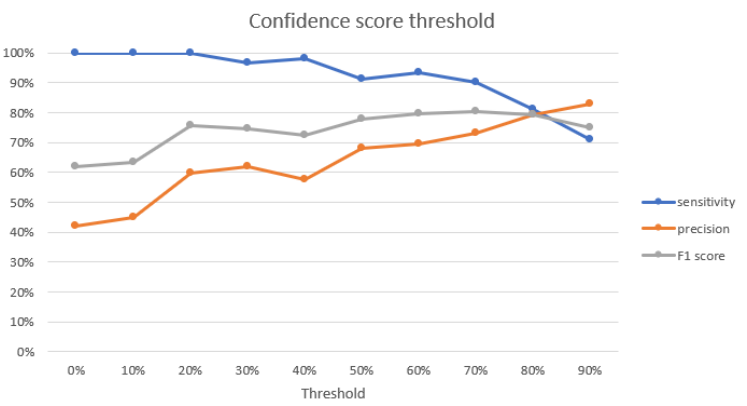
Figure 4. Sensitivity and precision metrics depending on the confidence score